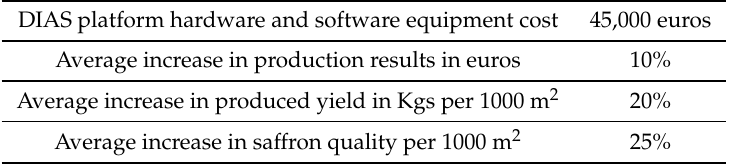
Table 7. Economic estimation for Greek saffron cultivation via using the DIAS platform in one